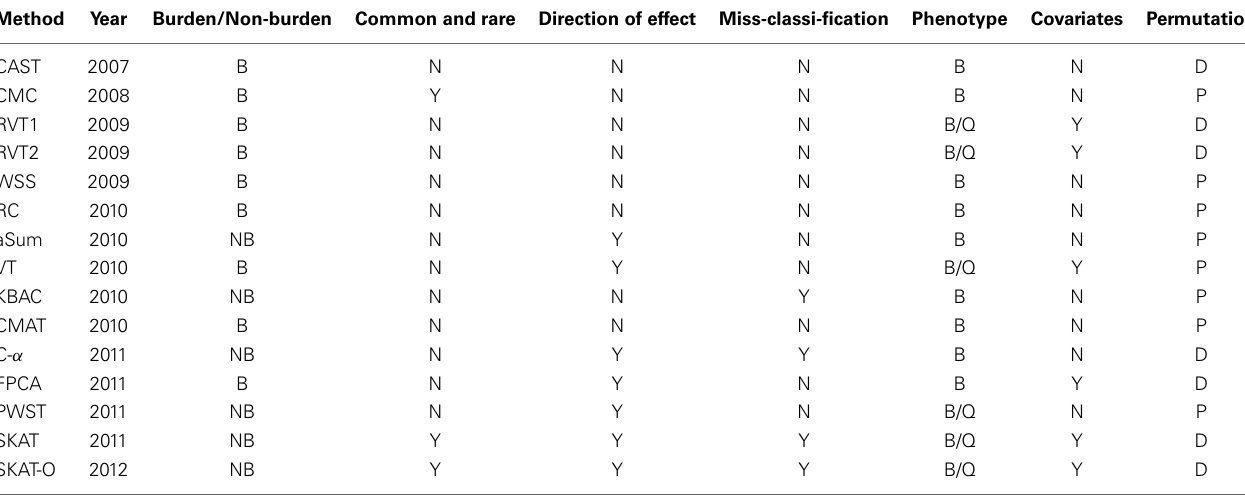
Table 1 | Properties of 15 collapsing methods: Year of publication, burden (B) or non-burden (NB) test, both common and rare variants used in the analysis [yes (Y)/no (N)], test considers different effect directions (Y/N), test able to handle the presence of non-causal variants (Y/N), phenotype quantitative (Q) and/or binary (B), covariates can be included (Y/N), p -values assessed by permutation (P) or from an asymptotic distribution